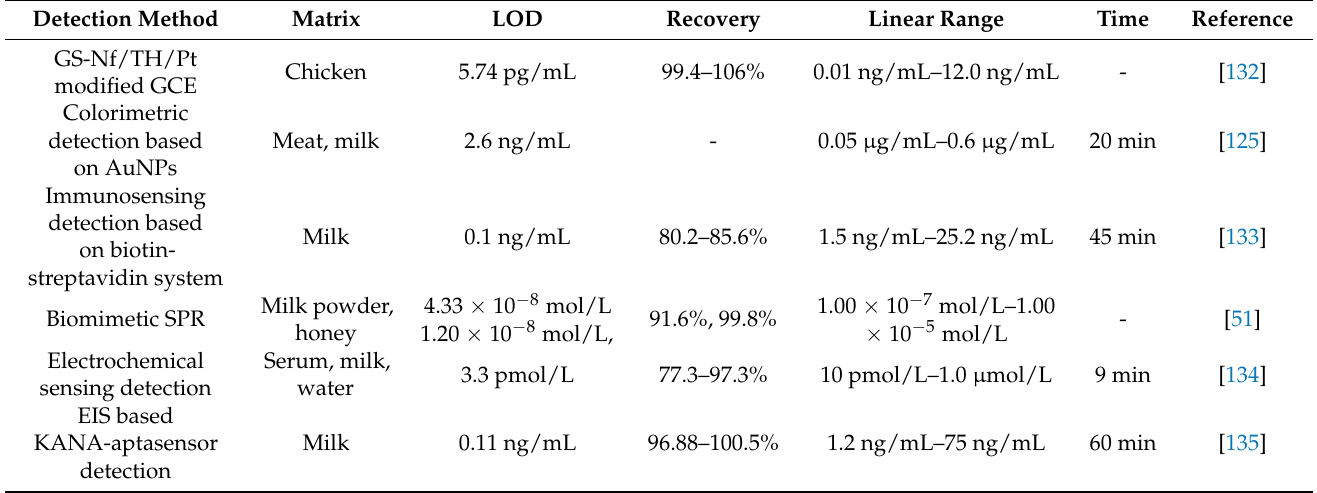
Table 5. Detection of kanamycin in animal food by affinity-based analysis